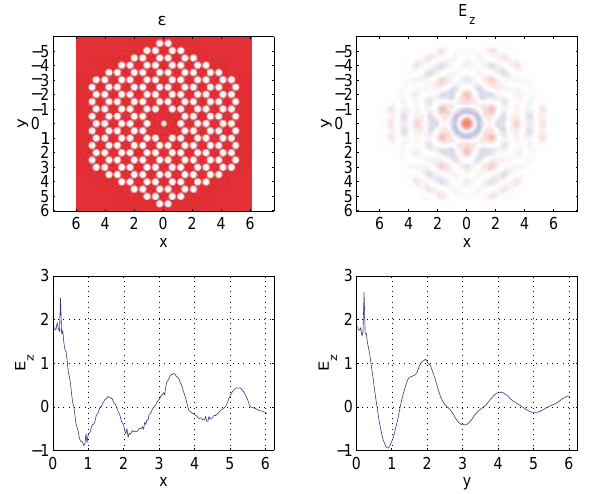
FIG. 10. (Color) Defect mode in a honeycomb